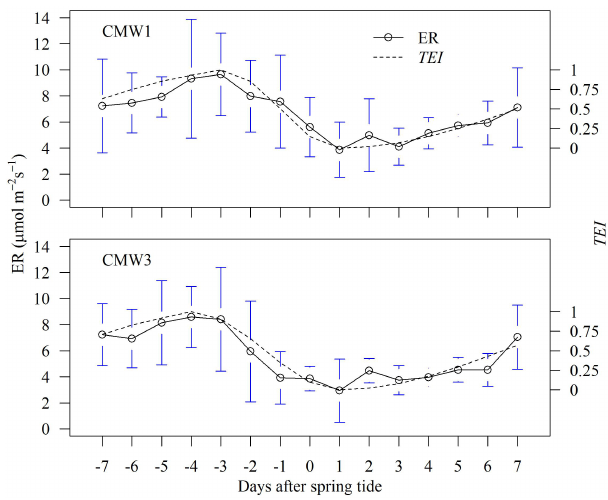
Fig. 2. Variation of ER (ecosystem respiration) during spring–neap tidal cycles in summer. Solid line represents ER, and dashed line represents normalized fit of TEI (tidal effect index). Top plot is for CMW1, and bottom plot is for CMW3.